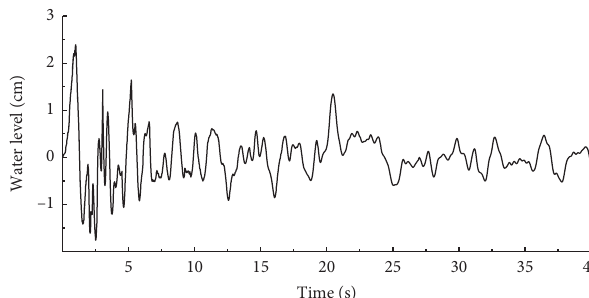
Figure 7: Water level of landslide-induced wave at position